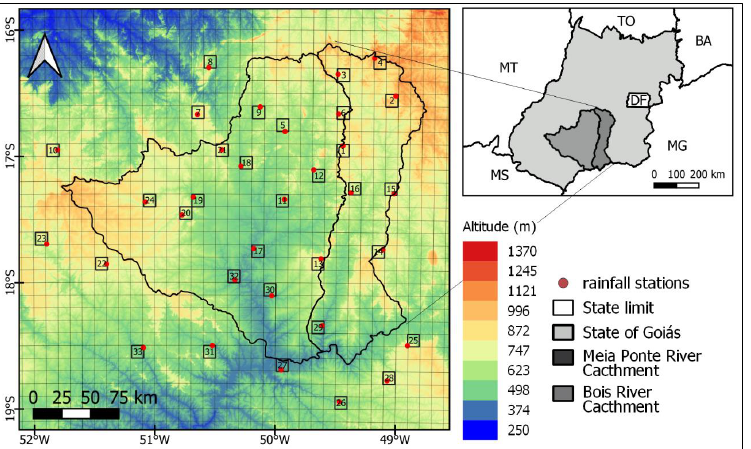
Figure 1. Locations of the Meia Ponte and Bois River catchments, rainfall gauging stations, elevations and sampling points utilized in this study. Black squares represent the 33 gauging stations (shown as reference numbers; see Table 1) utilized in the comparison with the 0.1° × 0.1° GPM pixels. Table 1. Rainfall gauging stations utilized for the estimation of spatialized precipitation and for comparison with the GPM data. Reference Number in Figure 1